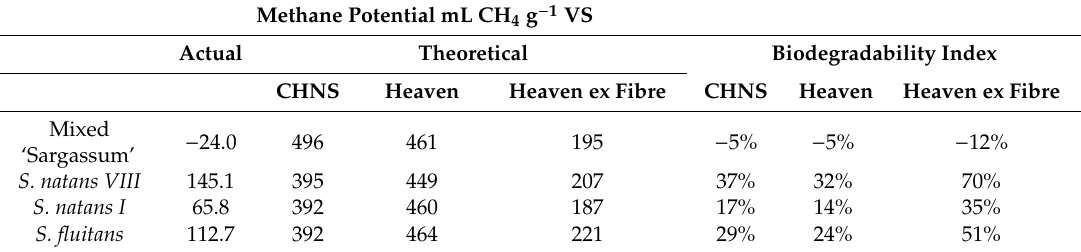
Table 11. The theoretical MP from the ‘Buswell equation’ based on CHNSO and the method of Heaven et al. [56] based on the lipid, protein and carbohydrate content (both including and excluding fibre) together with actual MP and biodegradability index (BI).